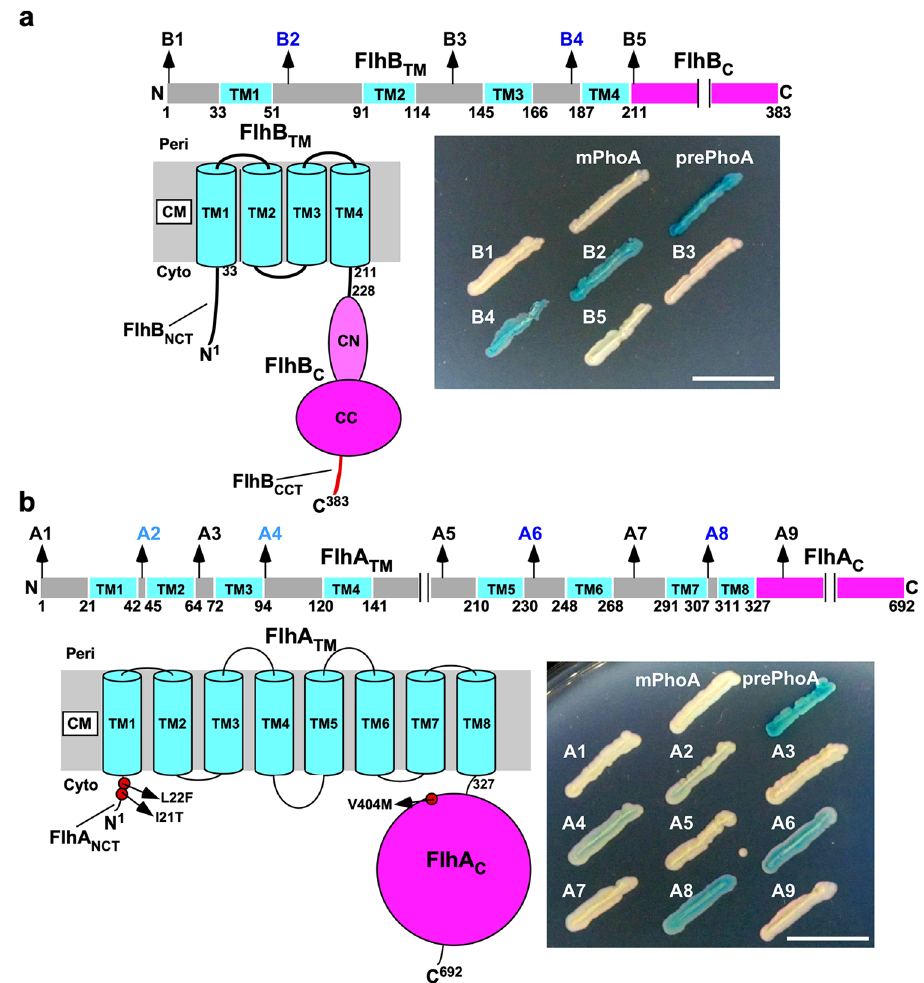
Fig. 9 PhoA fusion assays. a Membrane topology of FlhB. Salmonella TH12991 ( Δ phoN ) cells were transformed with pMKM10001